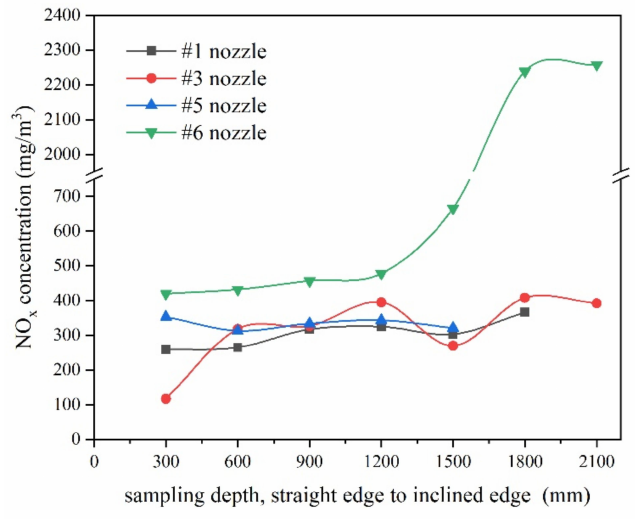
Figure 11. Horizontal distributions of NO x concentration at the different heights of the #B SNCR inlet.